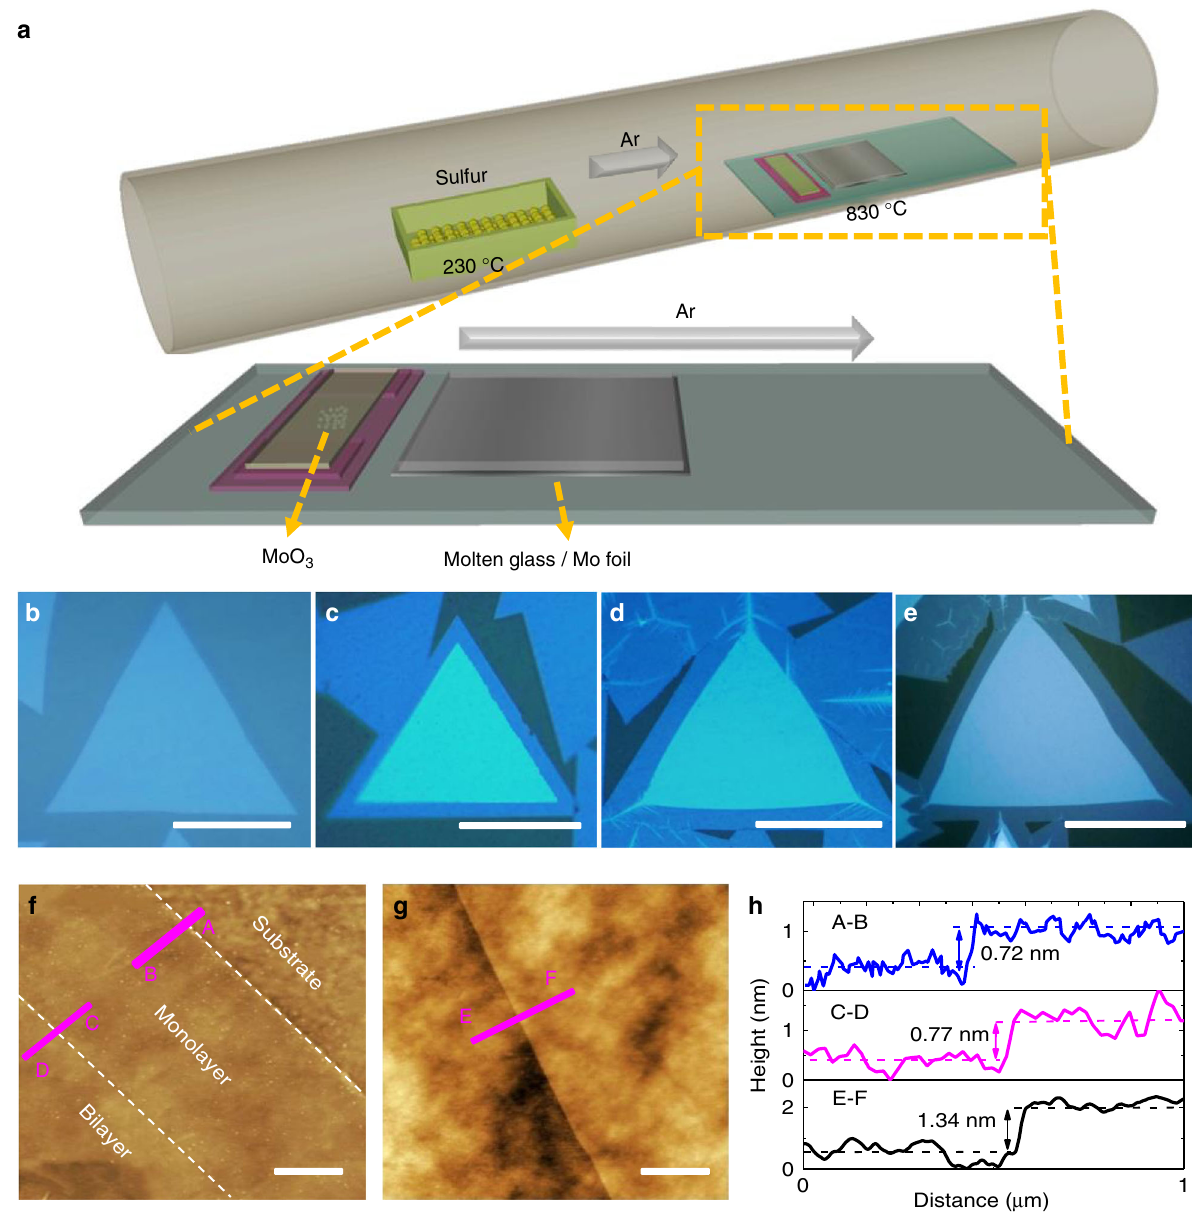
Fig. 1 Bilayer MoS 2 synthesis on molten glass and morphology characterization. a Schematic of the CVD setup for the synthesis of bilayer MoS 2 on molten glass. b – e Optical micrographs of CVD grown MoS 2 on molten glass; the corresponding weight of MoO 3 are 1, 1.5, 3, and 6 mg, respectively. Scale bars are 30, 40, 50, and 100 μ m, respectively. f , g AFM images of bilayer MoS 2 on SiO 2 /Si substrates after transfer. Scale bars are 1 μ m. h AFM data of line cut A – B, C – D, and E – F corresponding to the thickness of monolayer MoS 2 , the height difference of bilayer and monolayer MoS 2 , the thickness of bilayer MoS 2 , respectively. Panels f , g located at the edge and crack in the middle of bilayer MoS 2 fl ake,